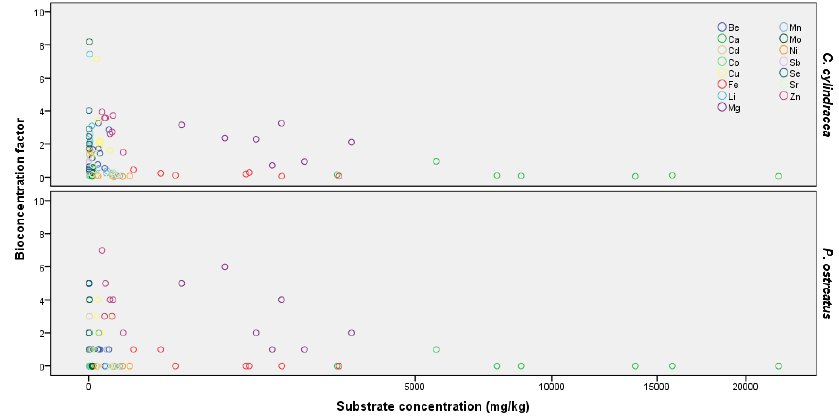
Figure 3. Scatter plot illustrating bioconcentration factors (mean values) of 15 elements in Cyclocybe cylindracea and Pleurotus ostreatus mushrooms produced on various substrates. AN: almond and walnut shells 1:1 w / w ; CC: corn cobs; GM: grape marc plus cotton gin trash 1:1 w / w ; OL: olive mill by-products (leaves and two-phase olive mill waste 1:1 w / w ); OS: extracted olive-press cake; PL: date-palm tree leaves; PN: pine needles versus elemental concentration of substrates.